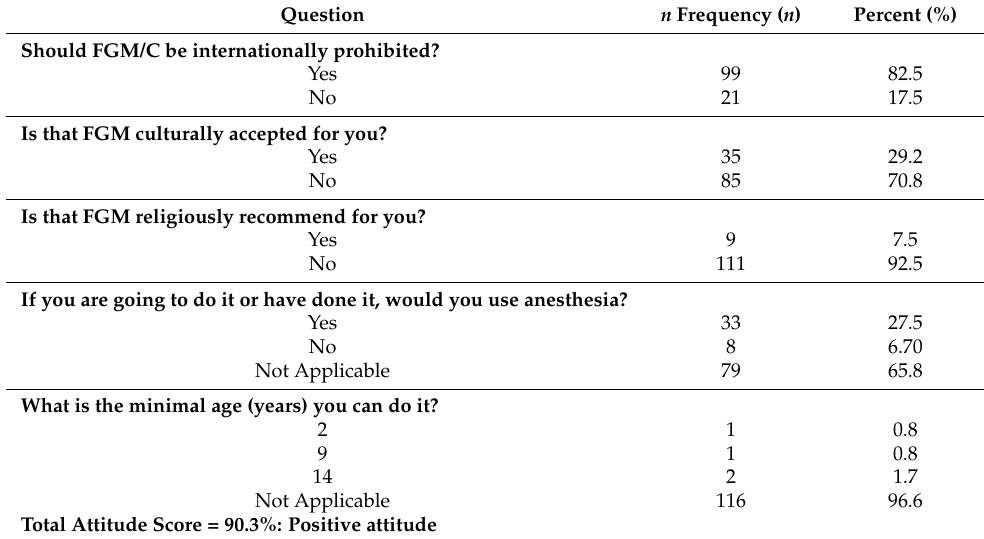
Table 2. Participants’ practice (attitude) about FGM ( n =